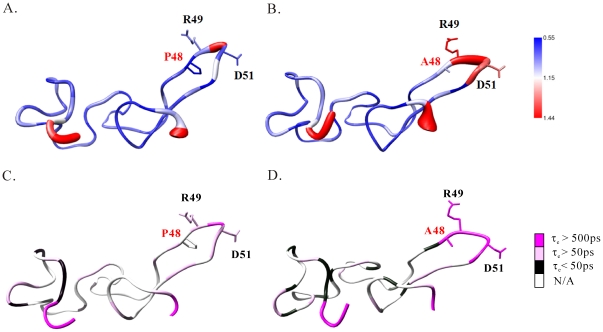
Representations of the dynamic properties of Rho and its P48A mutant.A sausage representation of the backbone dynamics of (A) Rho and (B) its P48A mutant. The diameter of the sausage is inversely proportional to the generalized order parameter of the corresponding residue. The side chains of P48/A48, R49, and D51 are shown. The magnitudes of the generalized order parameter are blue, white, and red. A representation of the effective internal correlation times of (C) Rho and (D) its P48A mutant. The residues containing the effective internal correlation times (τ
e)>500 ps, >50 ps, and <50 ps are shown in dark pink, light pink, and black. The residues without relaxation data and the fitting model are shown in white.